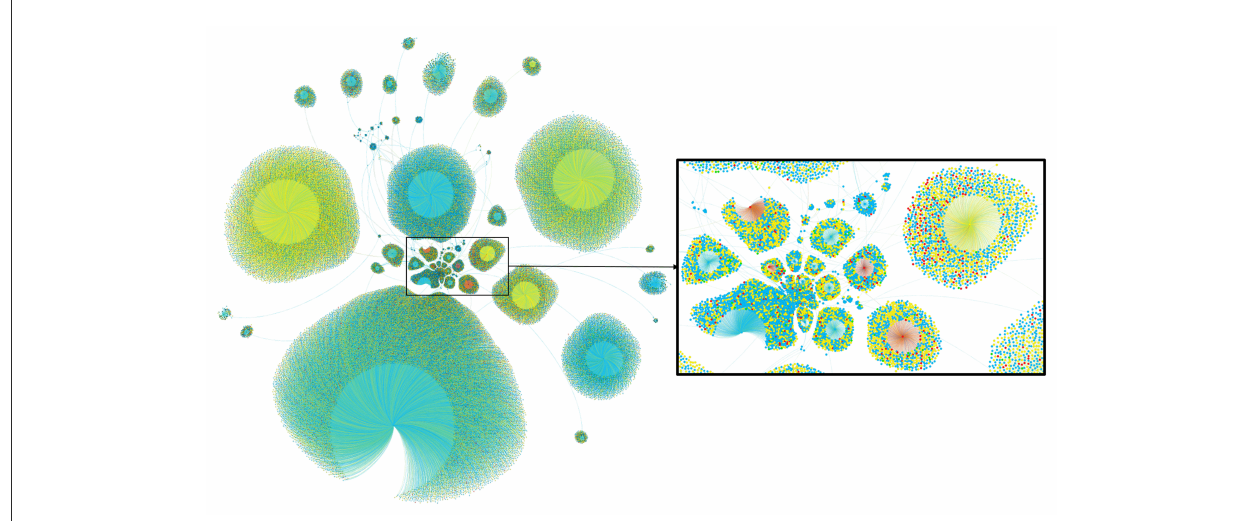
FIGURE6 Part of the sentiments forwarding network in Weibo posts and comments (green: Tag 0; blue: Tag 1; yellow: Tag 2; red: Tag